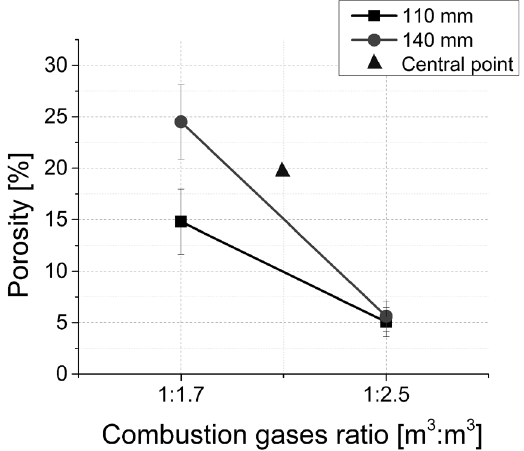
Figure 12. Effects plot of spraying parameters on coatings porosity